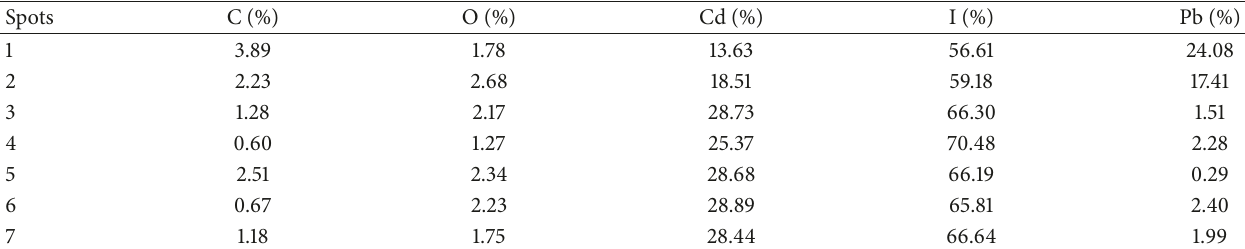
Table 2: Chemical composition of PbCdI 2 film, obtained for spots 1–7 shown in Figure 3(b).